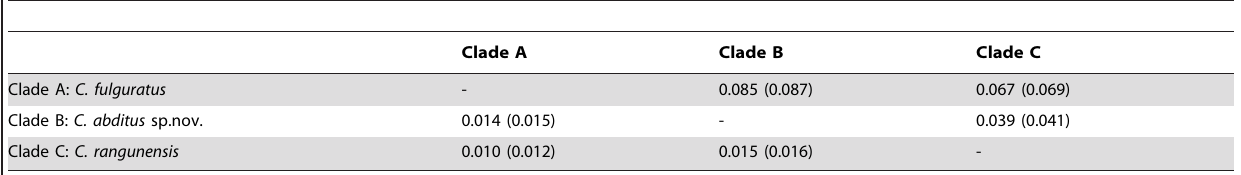
Table 4. Ranges of genetic divergence of three Cyclophorus fulguratus clades and related species based on 18S rRNA gene (above diagonal) and 28S rRNA (below diagonal).